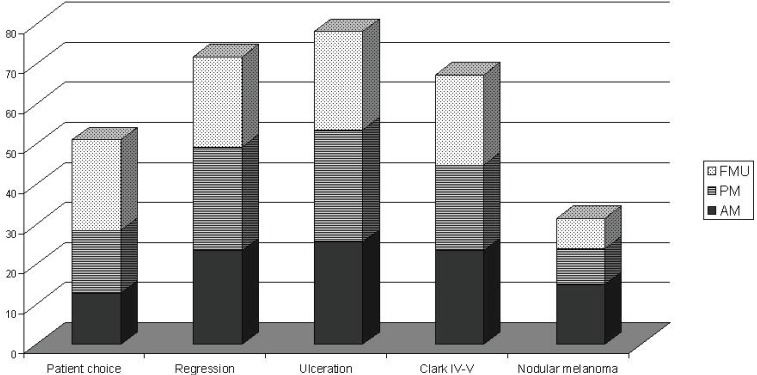
SNB for Breslow<1mm according to the EORTC status